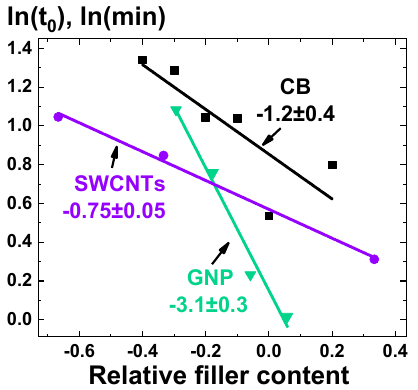
Figure 9. Dependences of the logarithm of the characteristic time t 0 of the fast (exponential) component (4) of the filler segregation kinetics on the relative filler content (5) for PP/CB, PP/GnPs, and PP/SWCNTs composites.